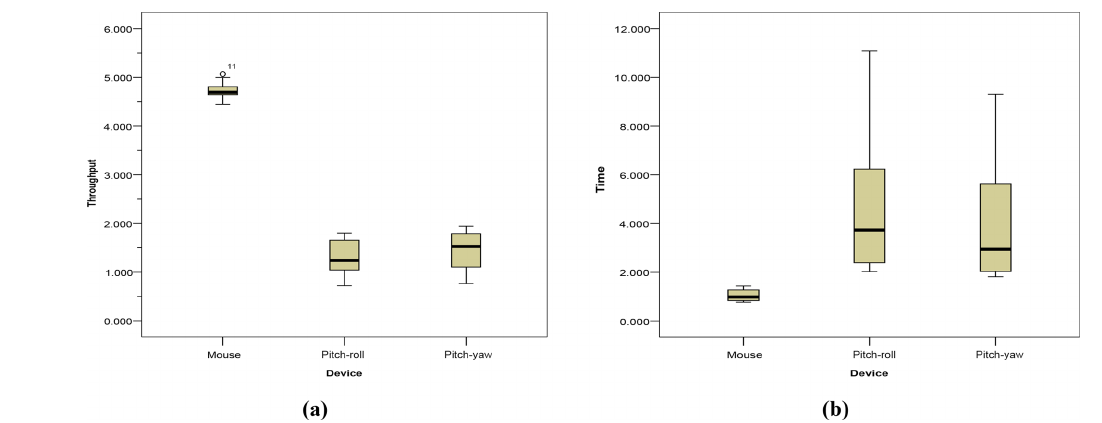
Figure 5. The boxplot of all data distribution related to (a) throughput (in bps) and (b) movement time (in seconds).